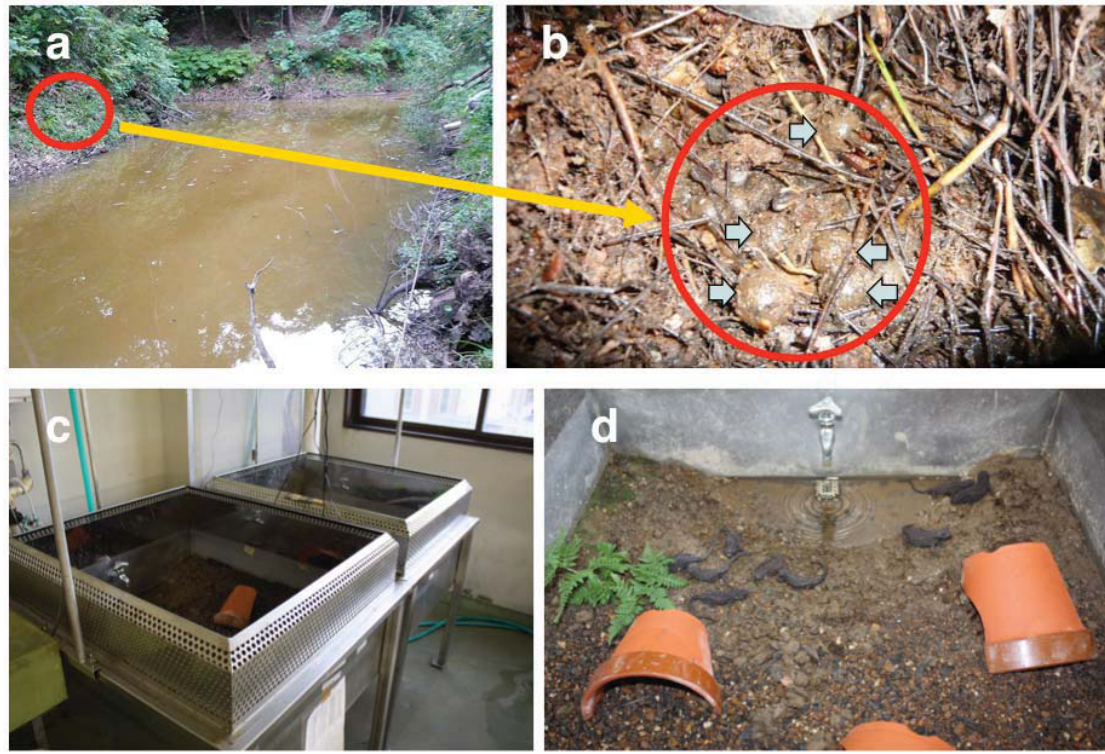
Figure 3. ( a , b ) Outdoor breeding site at Nago, Okinawa Island. Arrows indicate deposited